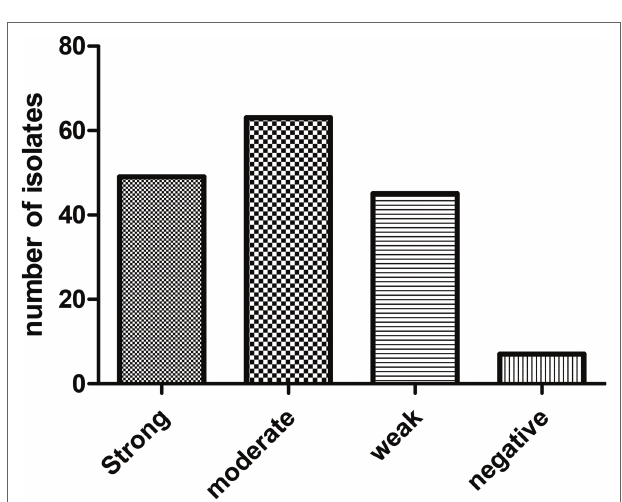
FIGURE 2 | Distribution of S. maltophilia isolates based on the biofilm formation in crystal violet staining